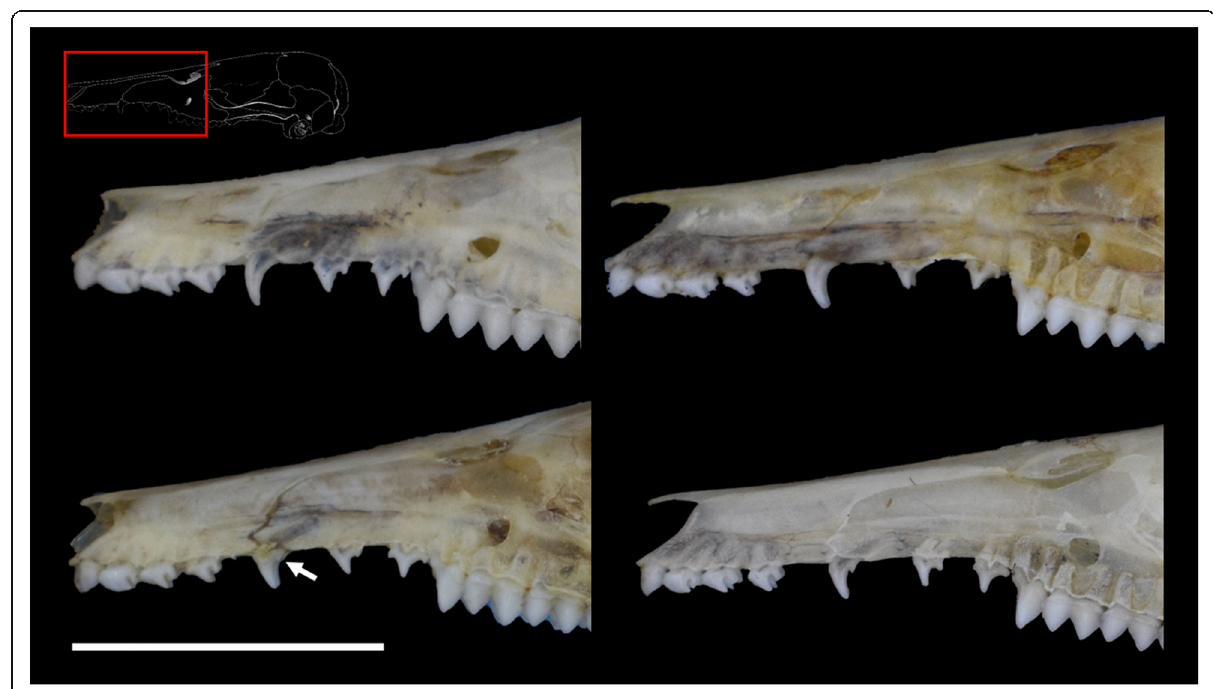
Fig. 5 Canine type variation in specimens of Rhyncholestes raphanurus Osgood showing the typical male-like canine (FMNH 50071 ♂ , top left; FMNH 124003 ♀ , top right), an intermediate, almost premolariform canine (FMNH 129831 ♀ , bottom left), and a typical female-like, premolariform canine (FMNH 129834 ♀ , bottom right). Scale bar: 1